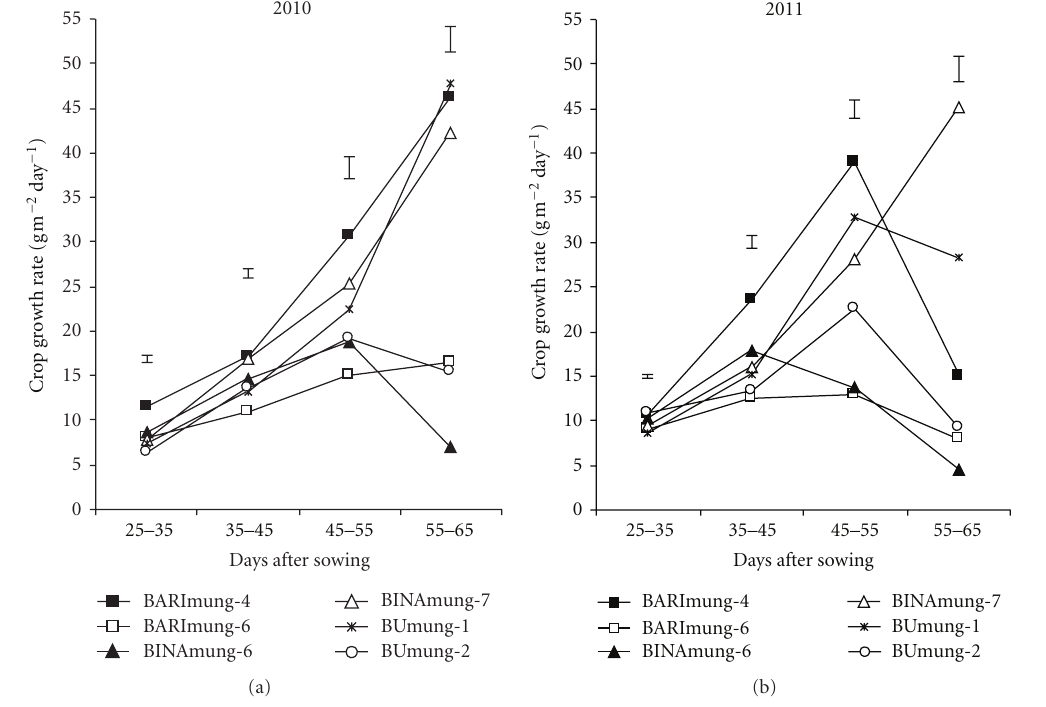
Figure 3: Pattern of crop growth rate in six mungbean varieties during their growth period. Vertical bars represent LSD